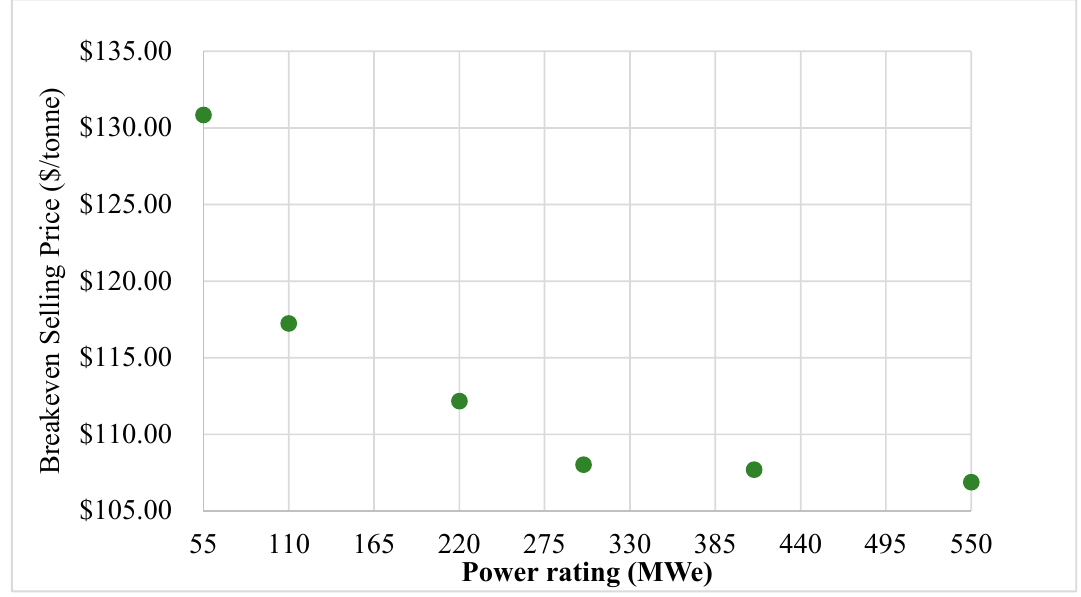
Figure 3. Breakeven selling price for hydrochar at different power ratings.